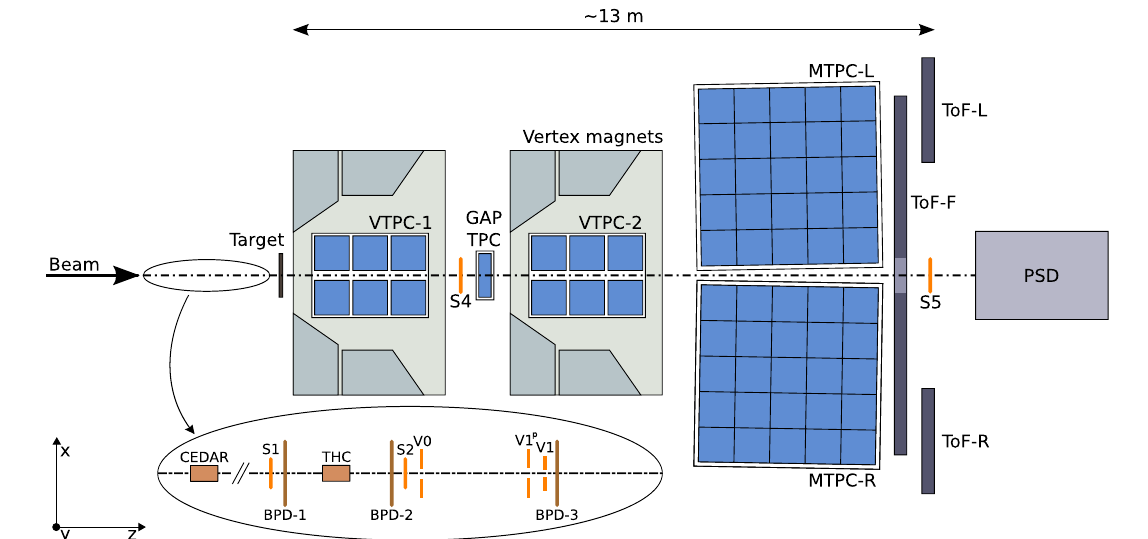
Fig. 1 Schematic layout of the NA61/SHINE experiment at the CERN SPS (horizontal cut, not to scale). The orientation of the NA61/SHINEcoordinate system is shown on the picture. The nominal